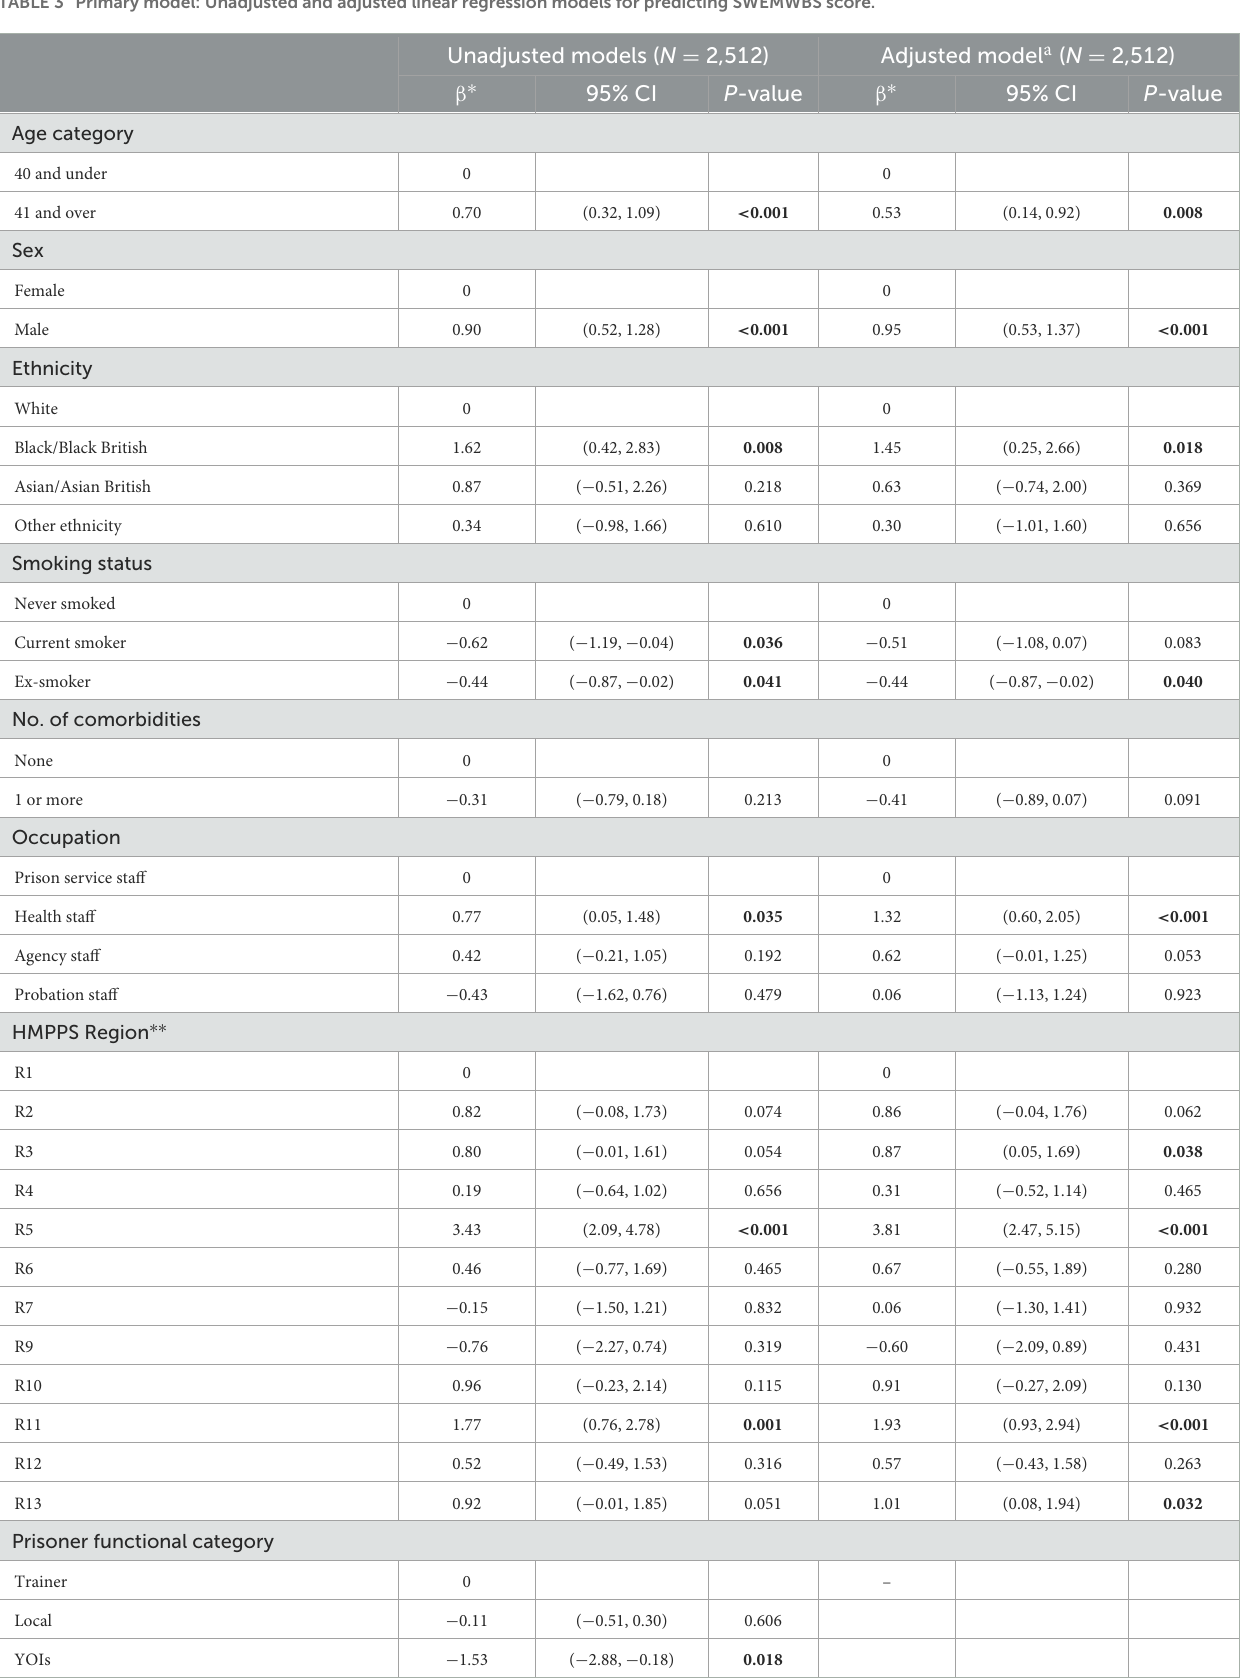
TABLE 3 Primary model: Unadjusted and adjusted linear regression models for predicting SWEMWBS score. Unadjusted models ( N =